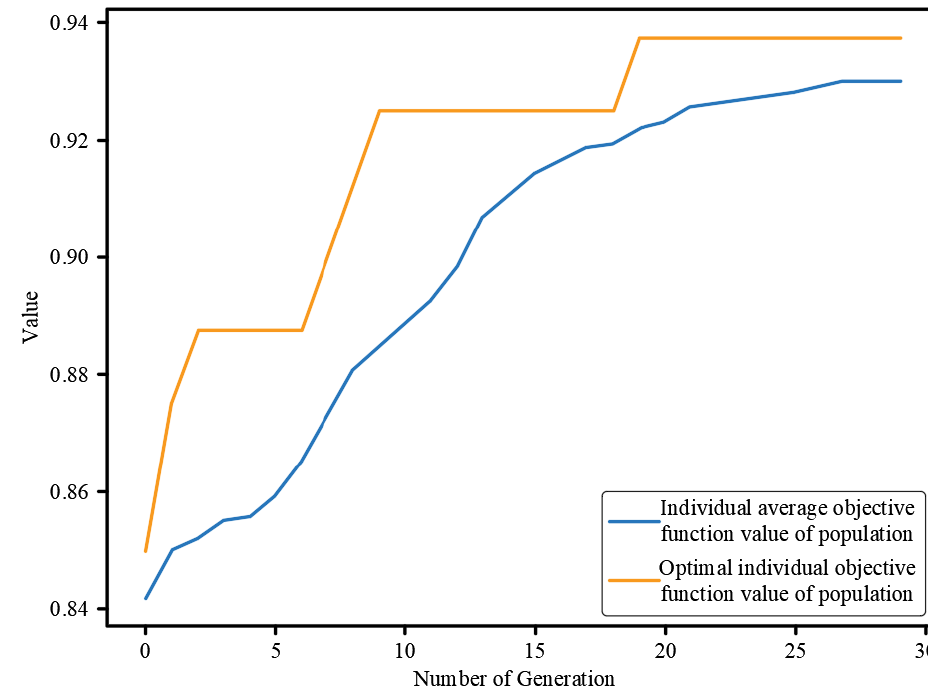
Figure 7. Iterative effect of the DE.